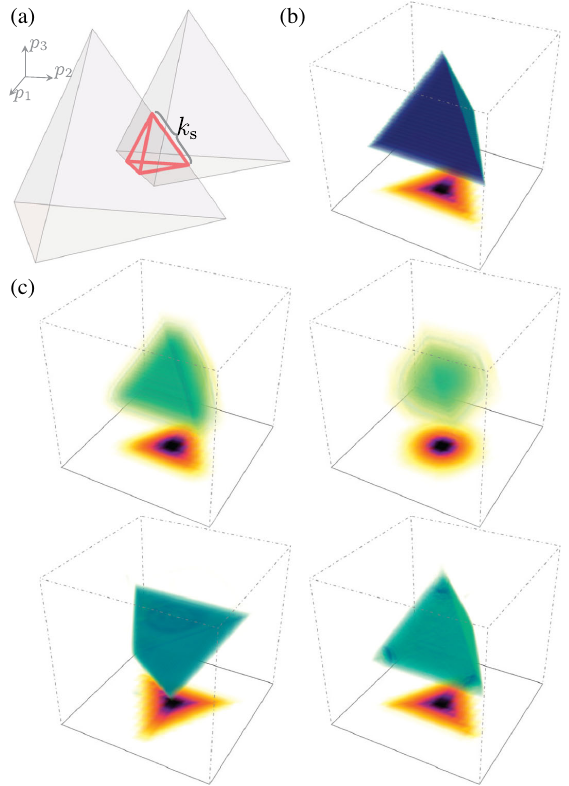
FIG. 4. Example II in 3D. (a) Schematic plots of the Wigner function uniformly distributed inside the intersection of two homothetic tetrahedra, and the intersection area, as enclosed by the red boundaries, is still a tetrahedron. (b) The initial density distribution. (c) Dynamics of the density distributions at t ¼ T= 16 ; T= 8 ; T= 4 ; T= 2 obtained by numerically solving the gen- eralized Gross-Pitaevskii equation with a scale-invariant pressure term in three